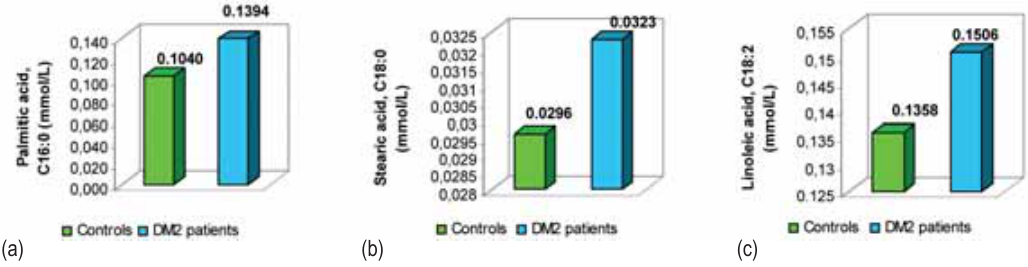
FIGURE 1. Average concentration of palmitic acid (a), stearic acid (b), linoleic acid (c) in plasma of patients with Type 2 dibetes mellitus and control subjects, no statistically signi fi cant.